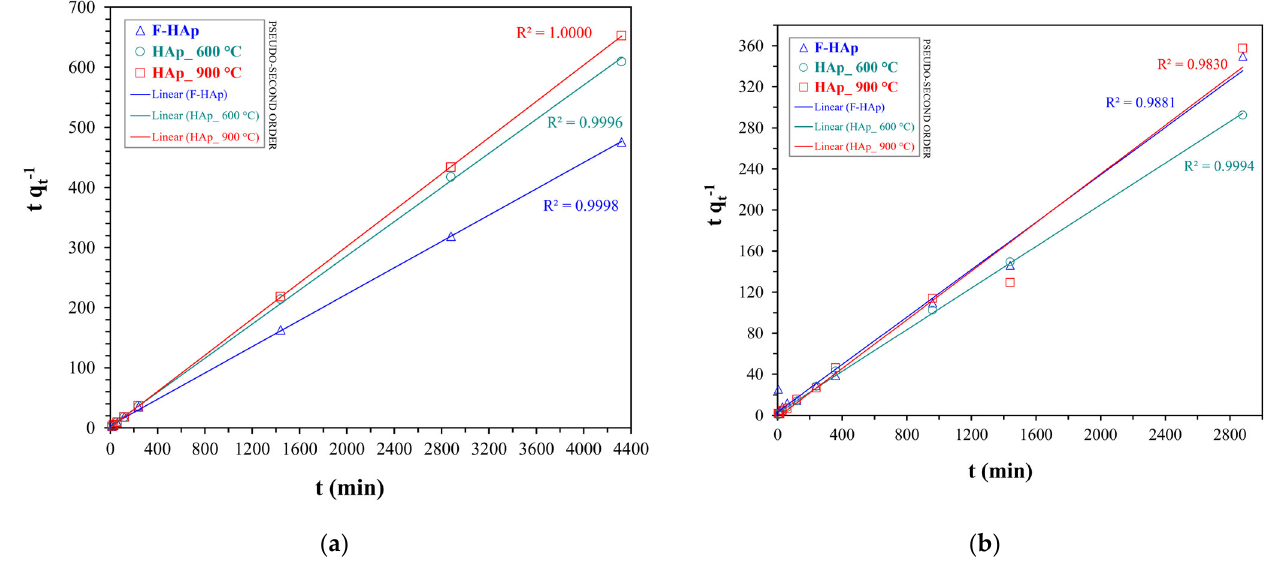
Figure 8. Linear fitting plots of pseudo ‐ second order kinetic model for ( a ) atrazine and ( b ) cobalt Figure 8. Linearfitting plotsof pseudo-secondorderkinetic modelfor ( a ) atrazine and( b )cobalt adsorption.